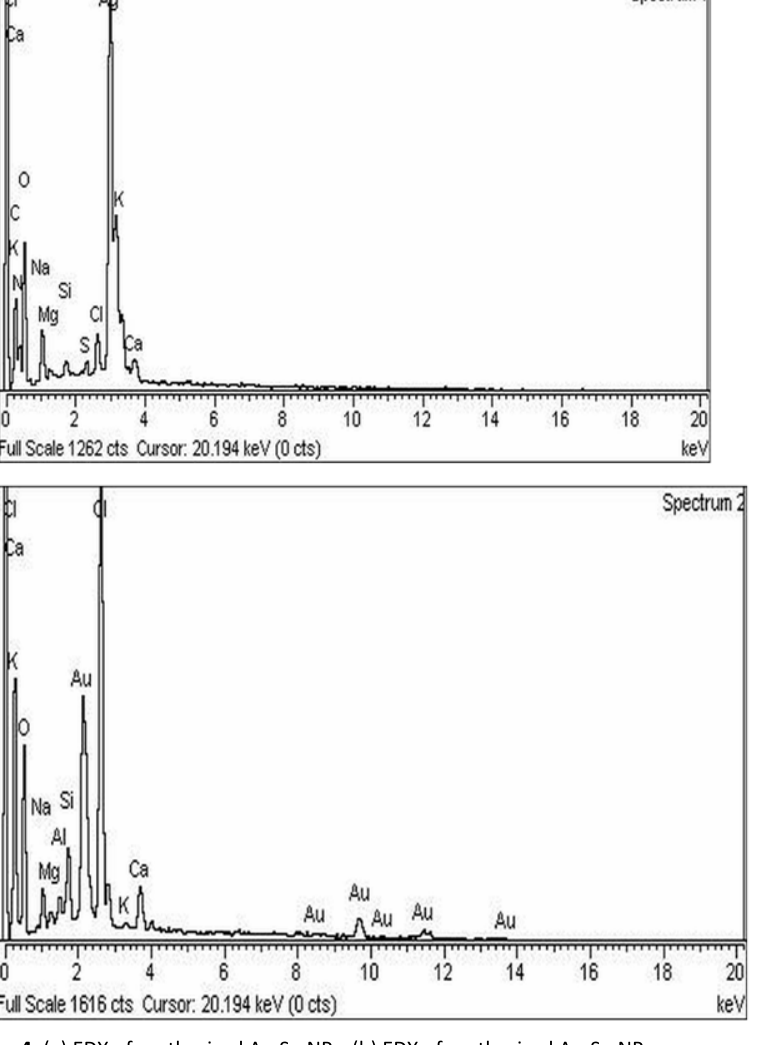
Fig. 4. (a) EDX of synthesized Ag-Sp NPs, (b) EDX of synthesized Au-Sp NPs